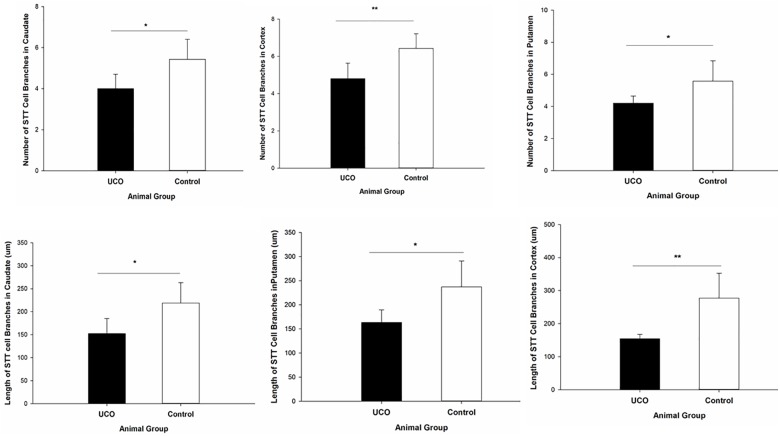
Morphological analysis of STT interneurons showed a significant effect of UCO on the length and number of the STT dendrites in cortex, caudate, and putamen. Mean ± SD. ∗p < 0.05, ∗∗p < 0.01.